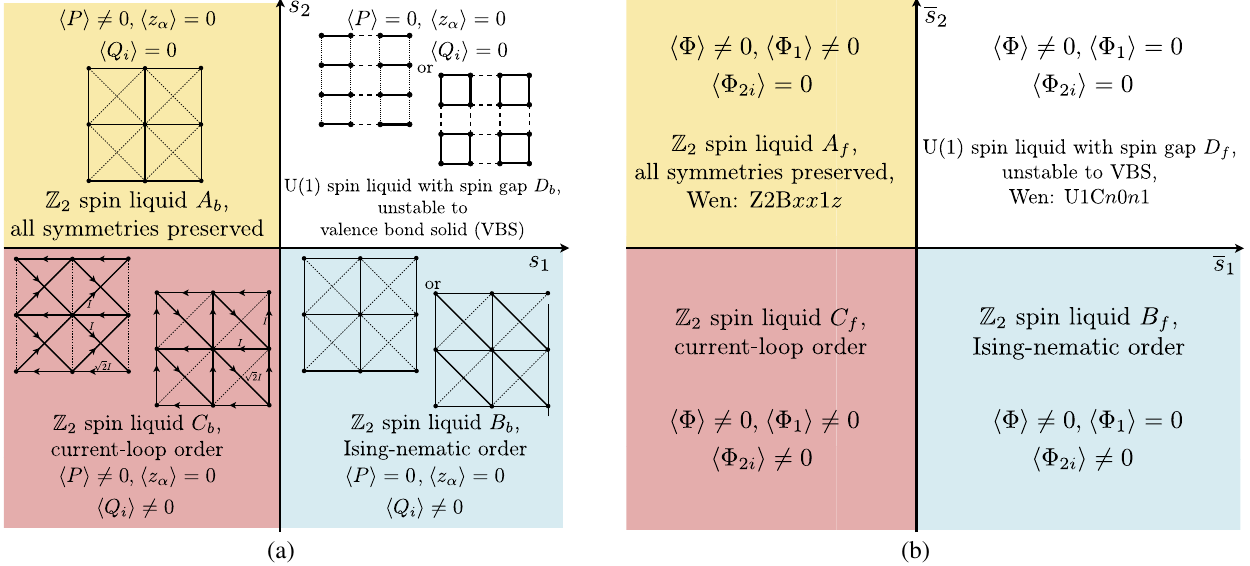
FIG. 2. (a) Schematic phase diagram of the CP 1 theory in Eqs. (1.4) and (1.7) as a function of s 1 and s 2 (for large g ). (b) Schematic 2 flavors of massless Dirac fermions in Eqs. (1.6) and (1.8) as a function of ¯ s phase diagram of the SU(2) QCD 3 theory with N f ¼ ¯ s 0 and j s j large). All four phases in (a) and (b) are argued to be topologically identical. So for the Z 2 (for s < B B C , and C . Phases B and C do not appear in Wen ’ s classification [17] because they break global symmetries. b ¼ f b ¼ f f f